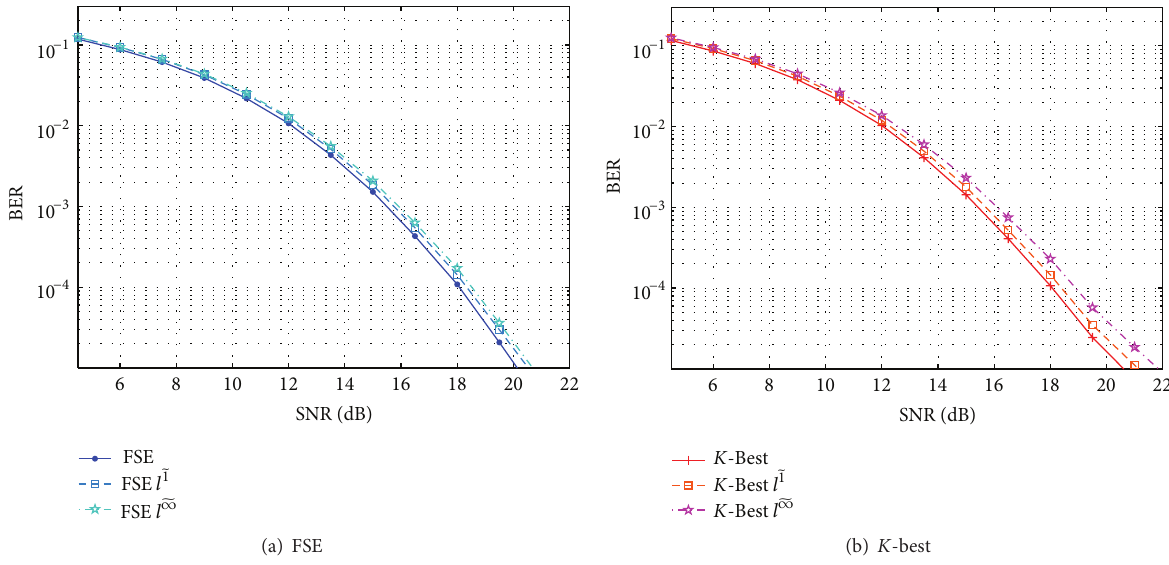
̃1 and ℓ ̃∞ norms in the FSE ( 𝑛 𝑇 = 10 )